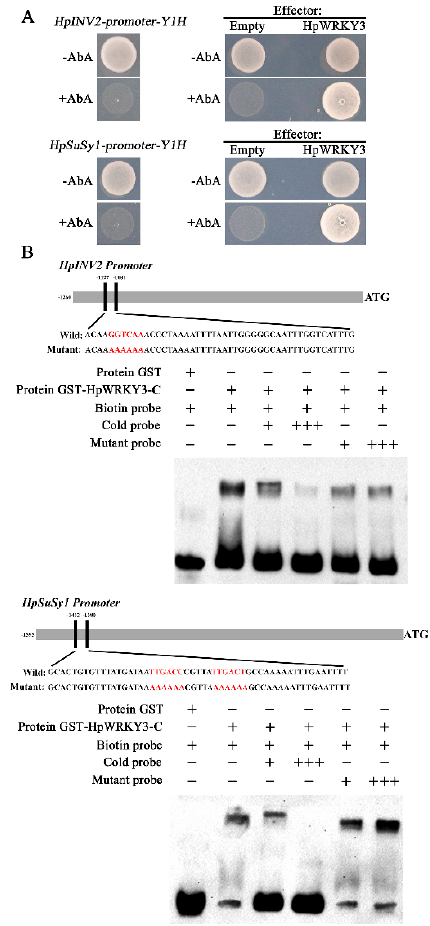
Figure 3. HpWRKY3 directly bind to HpINV2 or HpSuSy1 promoter. ( A ) Y1H assay showing the physical interaction of the HpWRKY3 protein with HpINV2 or HpSuSy1 promoter. ( Left ) No basal expression of HpINV2 - or HpSuSy1 -pro was detected in yeast grown on synthetic dropout (SD) medium lacking Leu (SD / − Leu) in the presence of 500 ng / mL Aureobasidin A (AbA) for stringent selection. ( Right ) Yeast growth assays were performed after the Y1H reporter strains were transformed with plasmids carrying cassettes constitutively expressing HpWRKY3 e ff ector or empty (pGADT7, negative control). Interaction was determined based on the ability of transformed yeast to grow on SD / − Leu in the presence of AbA. All suspensions of yeast cells in this assay were adjusted to OD 600 = 0.1. ( B ) Electrophoretic mobility shift assay (EMSA) showing the binding of HpWRKY3 to the W-box of the HpINV2 or HpSuSy1 promoter. Purified glutathione-S-transferases (GST)-tagged HpWRKY3 protein were incubated with the biotin-labeled wild-type probe containing W-box, and the DNA–protein complexes were separated on native polyacrylamide gels. Sequences of both the wild-type and mutated probes are shown at the top of the image (wild-type and mutated W-box are marked with red letters). The probe with the mutated W-box was used to test binding specificity. Shifted bands, suggesting the formation of DNA–protein complexes, are indicated by arrows. “ − ” represents absence, “ + ” represents presence. “ +++ ” indicates increasing amounts of unlabeled or mutated probes for competition experiments.